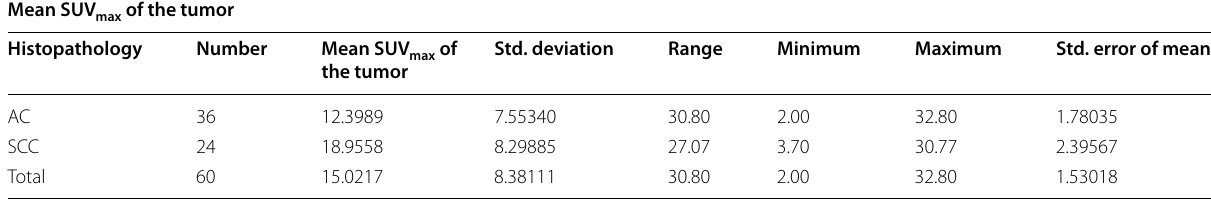
Table 3 Shows the mean SUV of the tumor including the standard deviation, and range based on the histopathological max